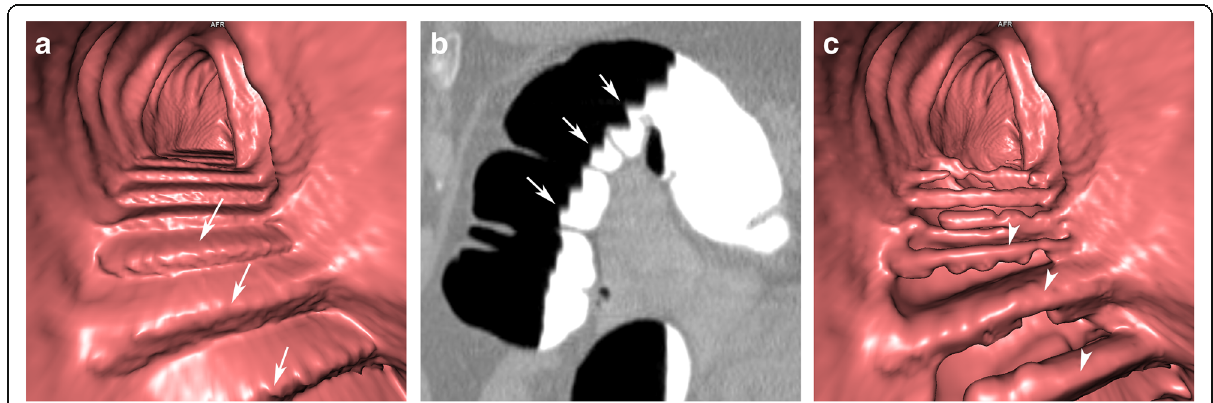
Fig. 6 Fluid motion artefacts at the interface between tagged residues and air in the descending colon. a Endoluminal 3D view and ( b ) sagittal 2D view showing stair-step artefacts at the air-fluid layer related to fluid motion in the colonic lumen (arrows). Note that the colonic wall shows no artefacts. c EC is incomplete leading to a grid-like artefact at the air-fluid layer (arrowheads)